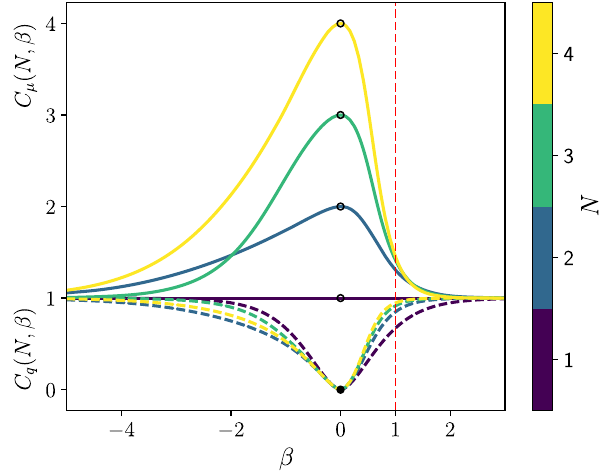
FIG. 11. Classical memory C μ ð N; β Þ (solid lines) and quantum memory C q ð N; β Þ (dashed lines) required for generating process P ð N; β Þ for interaction ranges N ¼ 1 ; … ; 4 ; a range of β ∈ ½ − 5 ; 3 (cid:3) ; and δ ¼ 2 . At both limits, β → 0 þ and β → 0 − , C N; β Þ scales linearly with N , while C N; β Þ vanishes. For any μ ð q ð finite β , for sufficiently large N , C μ ð N; β Þ is an increasing function of N , while C q ð N; β Þ is bounded above by 1. The vertical dashed red line at β ¼ 1 shows the memory costs for generating typical